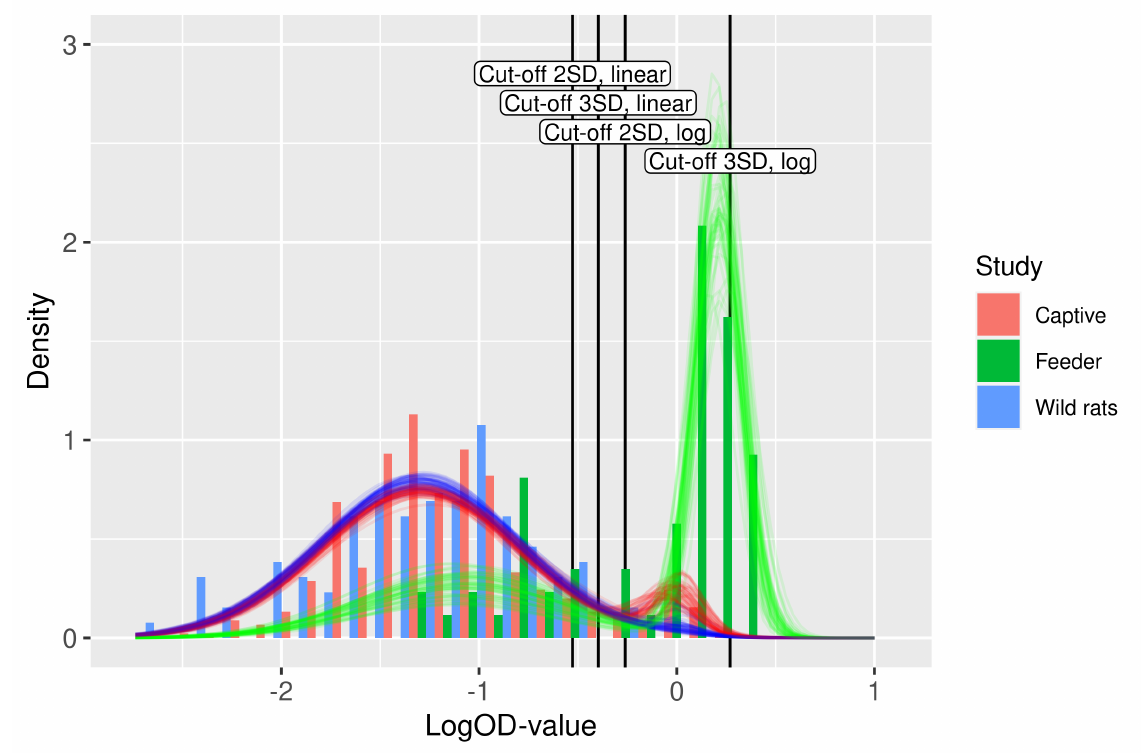
Figure 3. Fit of the binary mixture model (curves) to the ELISA logOD values (histograms). Each curve is plotted using a random draw ( n = 50) from the joint uncertainty distributions of the parameters in Table 2. Hence, the collection of curves gives an impression of the overall uncertainty in the model prediction. The color of the curves indicates the study. The four cut-off values are shown as vertical